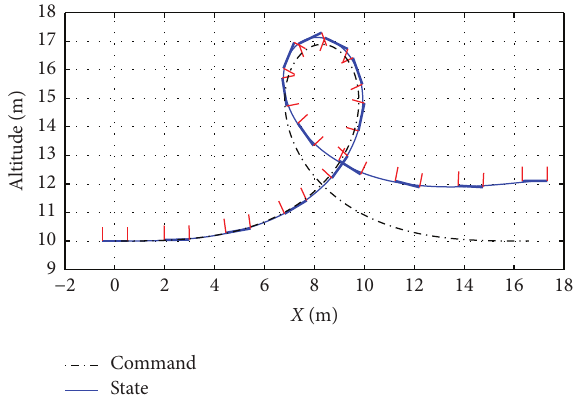
Figure 14: Quadcopter visualisation with P controller.